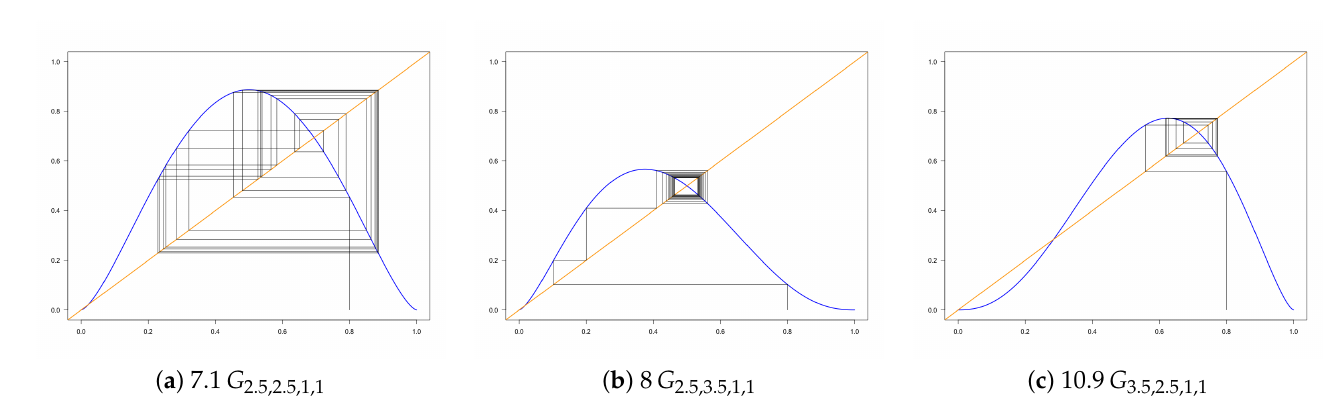
Figure 6. Hyper-logistic